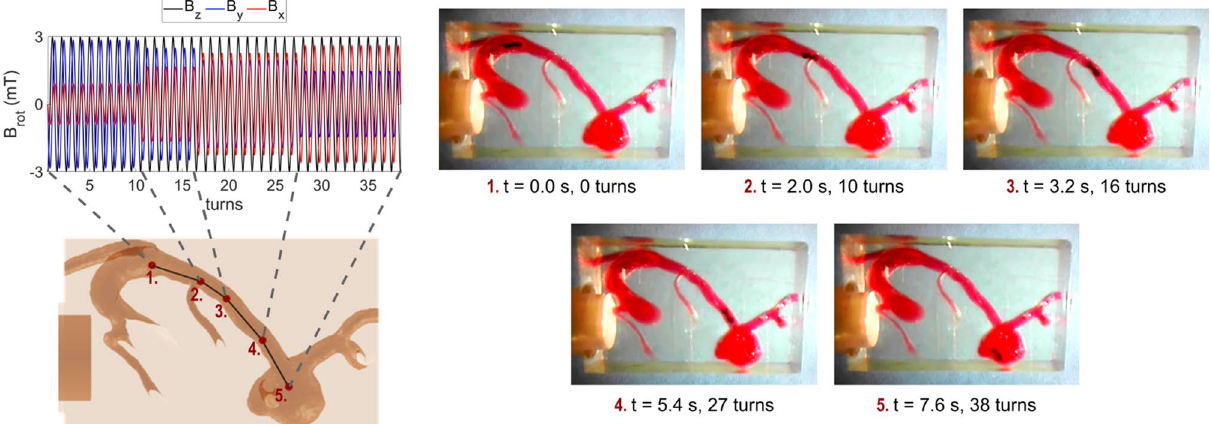
Figure 4. Navigation of the micro-robot with an MPI scanner through the aneurysm phantom. The path through the aneurysm phantom is approximated by four straight path segments by using the CAD model. According to the path segments the focus fields are calculated, such that the field vector rotates in the plane perpendicular to the path segment. A rotation frequency of 5 Hz and an amplitude of 3 mT is applied. The video stills show the resulting movement of the micro-robot through the human phantom, which was filled with a red stained glycerol-water mixture to mimic the viscosity of blood. The measurement is conducted inside an MPI scanner. The video can be found in the Supplementary Material.